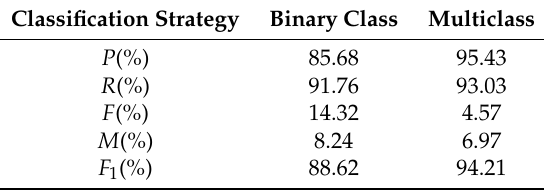
Table 4. Ship classification results with different classification strategies.